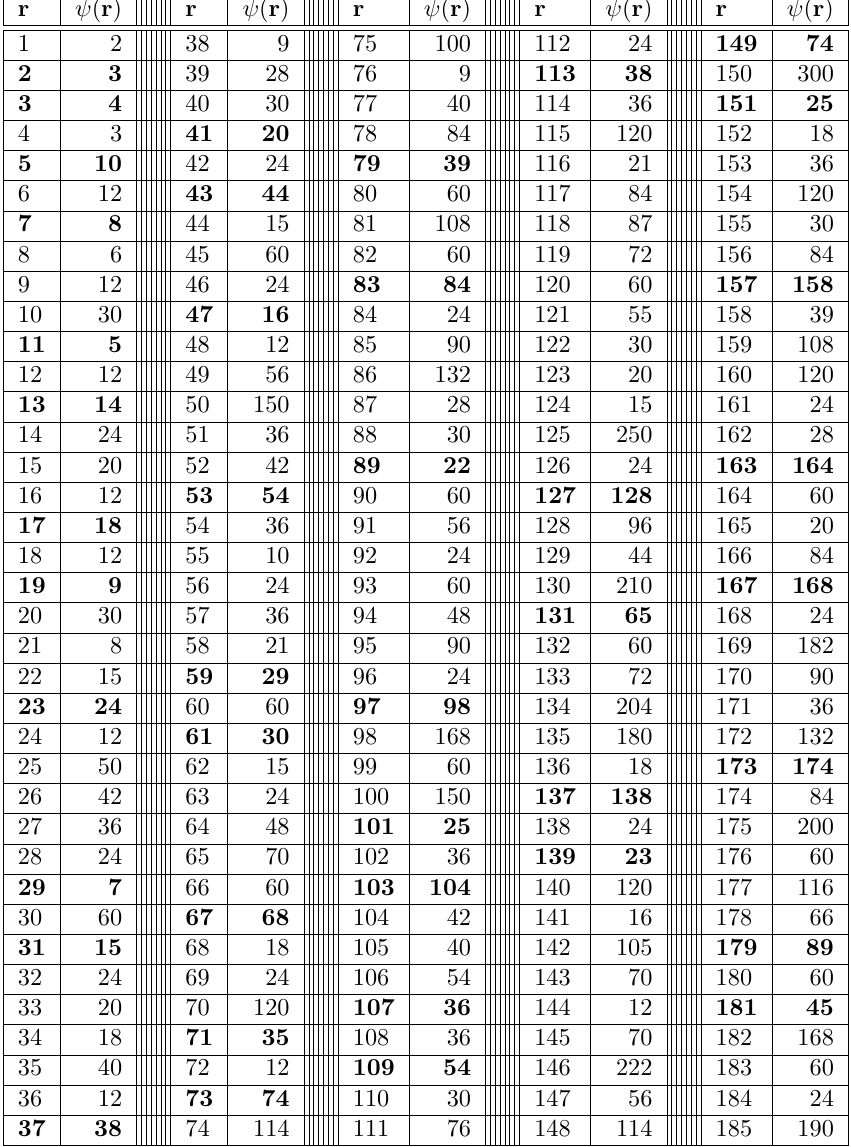
Tab. 2: Table of ψ . In bold: prime r ’s and their ψ